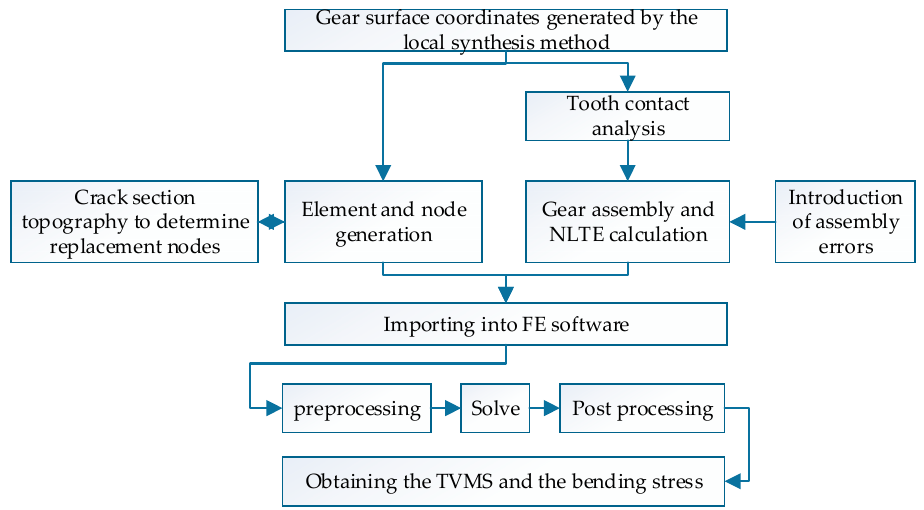
Figure 8. Flow chart of the FE modelling process.